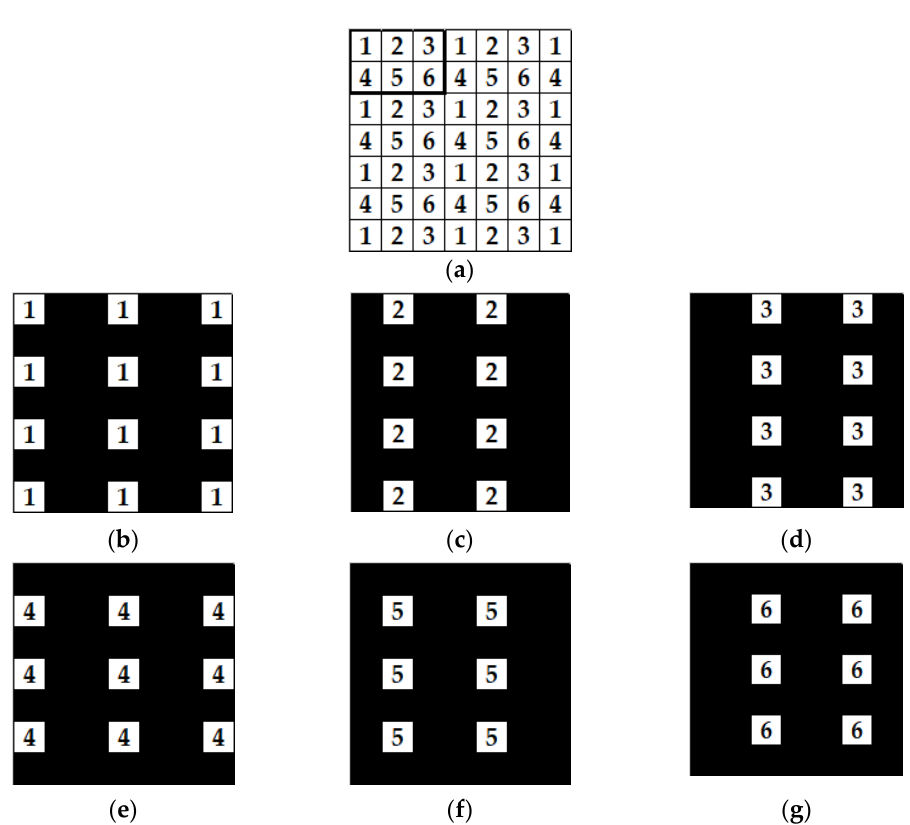
Figure 2. Original and pixel-separated images: ( a ) original image, ( b ) separated image of number 1, ( c ) separated image of number 2, ( d ) separated image of number 3, ( e ) separated image of number 4, ( f ) separated image of number 5, and ( g ) separated image of number